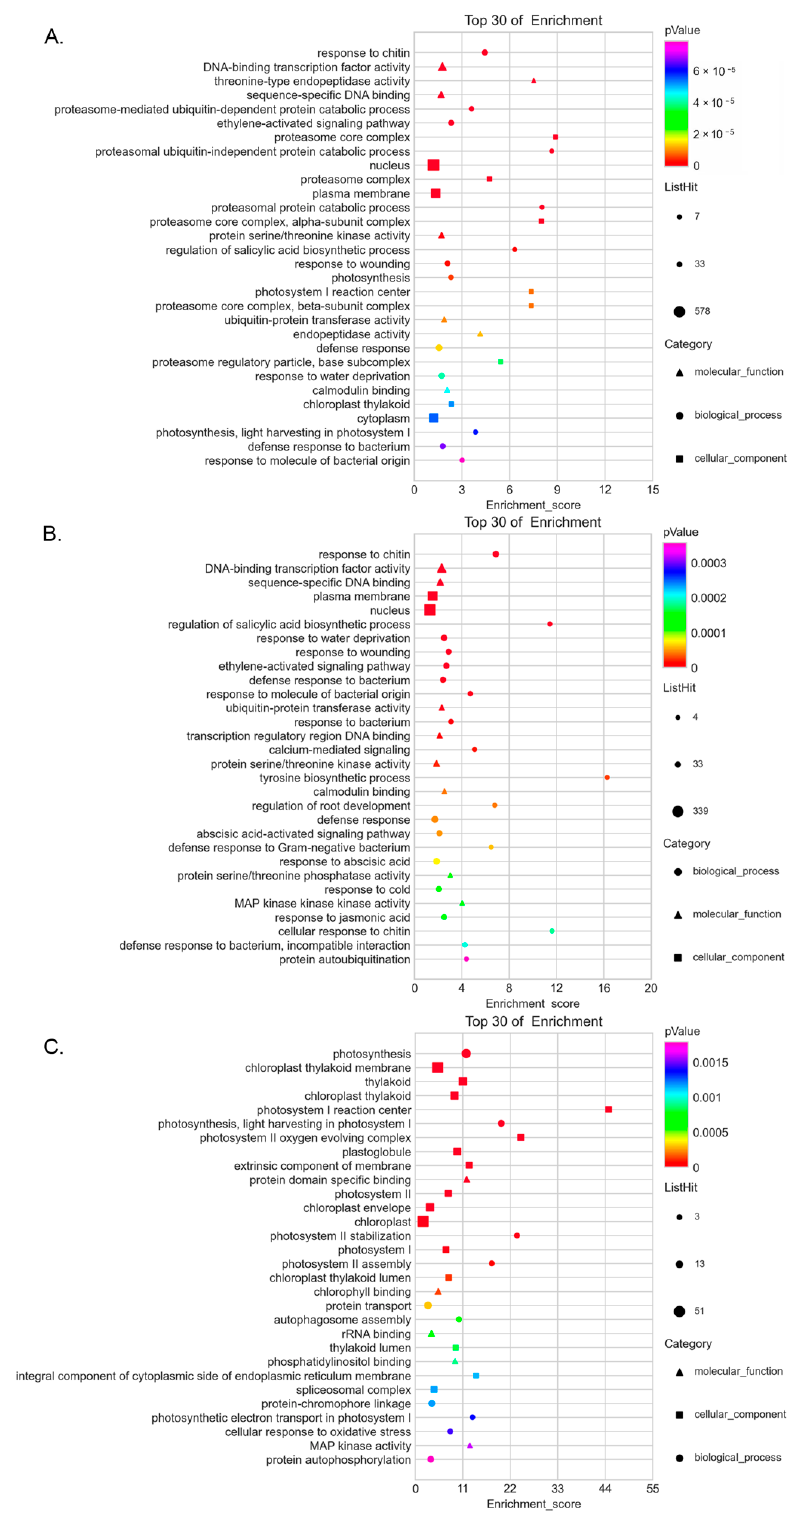
Figure 7. GO enrichment analysis of co-expressed genes with SlCRK genes. The Y axis corresponds to the GO term. The X axis corresponds to the Enrichment Score. Different shapes correspond to different GO categories (BP, CC, MF). The size of the dot corresponds to the number of different genes in the GO term and the bubble color is changed from purple-blue-green-red. The smaller the enrichment pValue, the greater the significance. GO enrichment analysis of co-expressed genes with all SlCRK genes ( A ), SlCRK genes of model 1 ( B ) and model 2 ( C